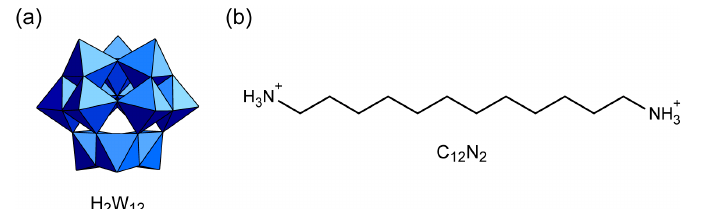
Figure 1. Molecular structure of utilized components: ( a ) Keggin-type metatungstate anion, [H 2 W 12 O 40 ] 6 − (H 2 W 12 ); and ( b ) Dodecamethylenediammonium, [H 3 N(CH 2 ) 12 NH 3 ] 2+ (C 12 N 2 ).